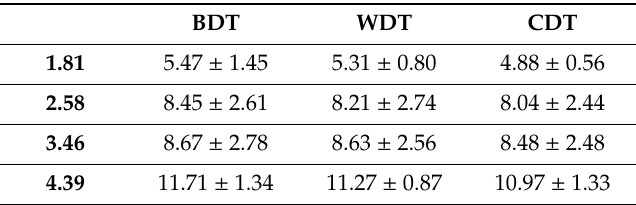
Table 4. Comparison of completion time with respect to performance metrics for between-day testing (BDT), WDT, and combined-day testing (CDT).